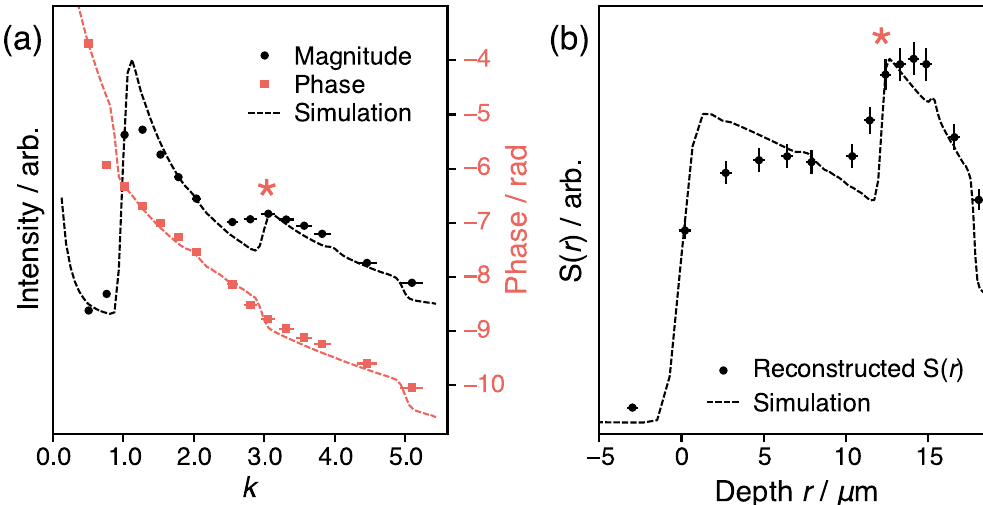
Figure 5. 7 Li experimental results obtained on a lithium metal strip. ( a ) Raw magnitude and phase data obtained by varying k (by changing τ ) in the pulse sequence in Fig. 2 with N = 16, Δ = 800 μ s and τ ( π - pulse) = 16 μ s for k = 1, as calibrated on 1 M LiCl(aq). The intensity of the on-resonance position in the spectrum is plotted. The simulated data are taken from the sum over all depths in Fig. 3. ( b ) Reconstructed S ( r ) slice profile from the results shown in ( a ). Error bars are derived from the errors in the pulse calibration (0.25 μ s error assumed on the calibrated π /2 pulse) and NMR signal intensities (taken as the standard deviation of the noise in each spectrum). Where errors are not visible they fall within the marker size. The asterisks indicate a jump due to the additional overtone signal at k = 3